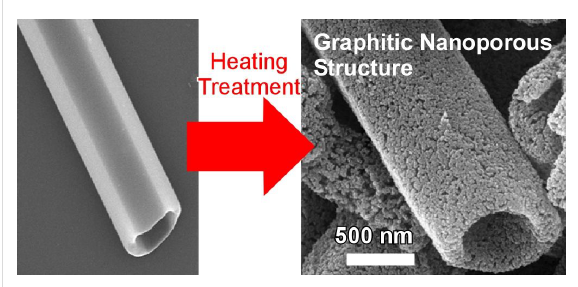
Figure 16: Conversion of one-dimensional C 60 nanotubes precipitated at liquid-liquid interface to one-dimensional carbon materials having sp 2 -carbon-based π -electron-rich robust mesoporous frameworks through carbonization at 2000 o C in vacuum.